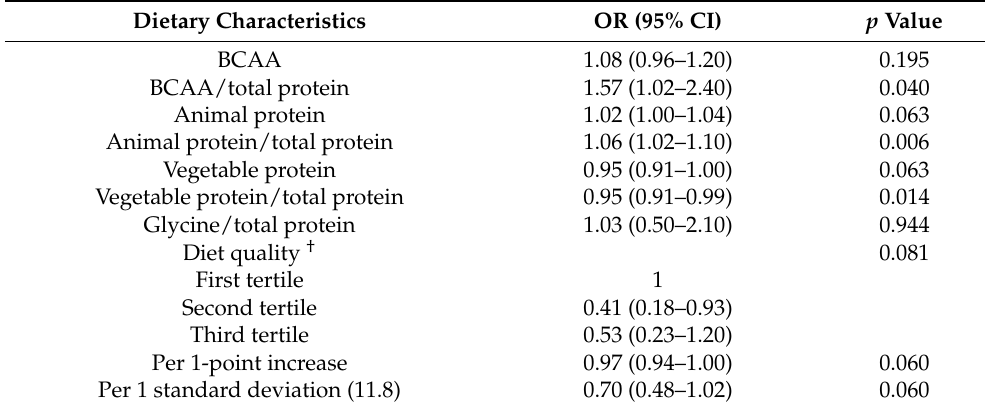
Table 4. Odds ratios (OR) and 95% confidence intervals (CI) for the association of dietary characteris- tics with incident GDM in the Year 7 subset ( n = 565), 1992–2011 *. Dietary